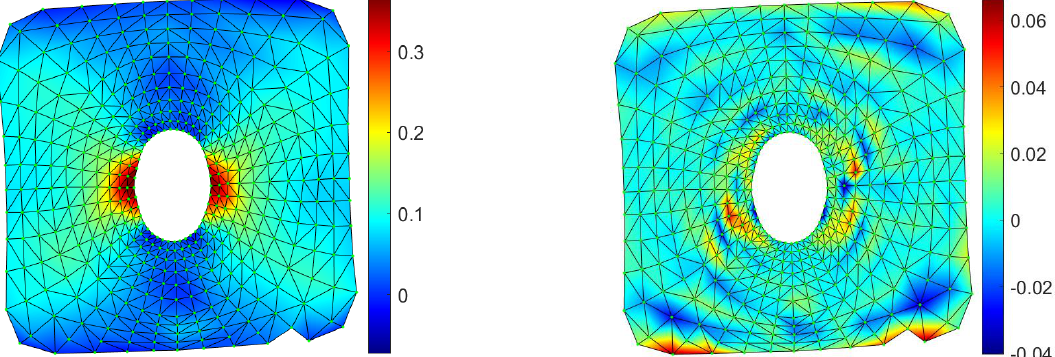
Figure 11. FEM contour map of the strain along the y direction for the drilled case ( left ) and its difference with respect to the proposed method ( right ).